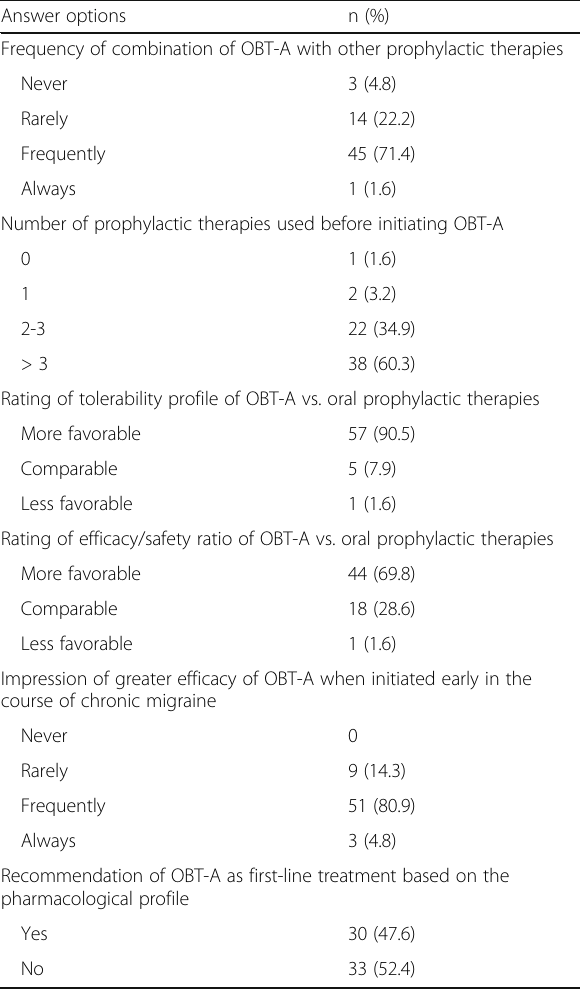
Table 2 Definition of response to treatment with Onabotulinumtoxin A (OBT-A) and treatment duration in chronic migraine